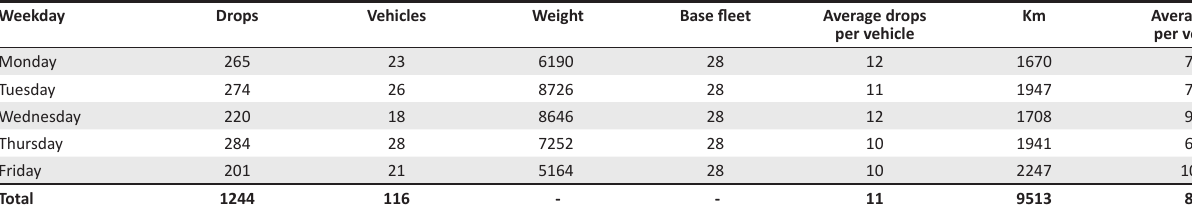
TABLE 5: Distribution centre 1 plan case study optimisation results.